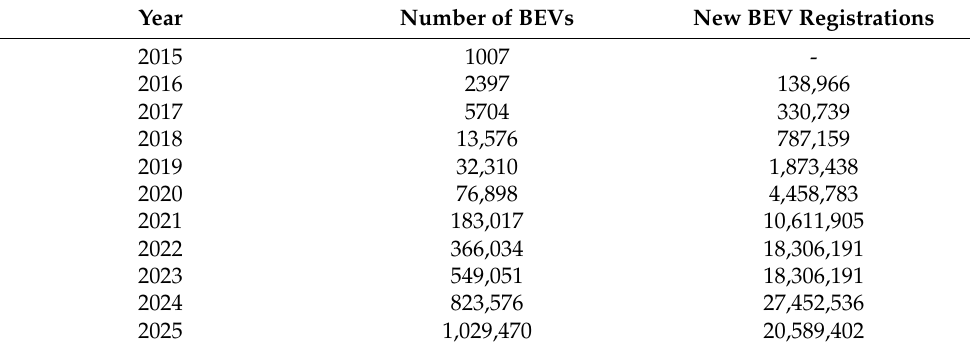
Table 1. Planned number of BEVs in the National Policy Framework for Alternative Fuel Infrastruc- ture